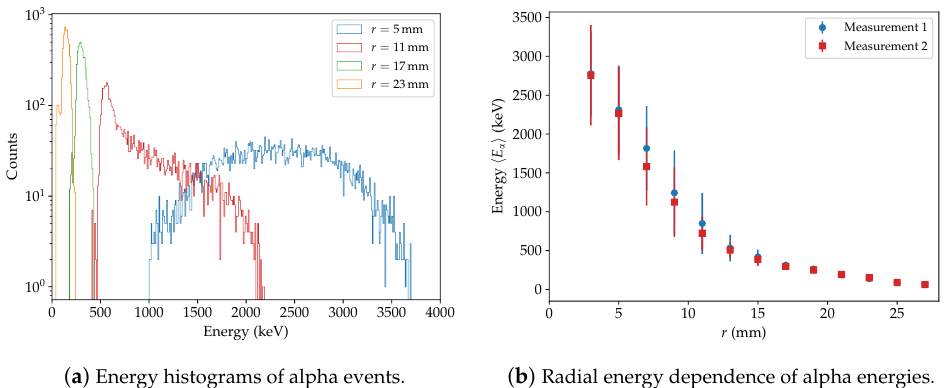
Figure 9. Radial dependence of the observed energy of alpha events: ( a ) Energy spectra of the alpha populations at selected radial positions after the application of multivariate cuts. ( b ) Mean observed alpha energy as a function of radius r for two radial 241 Am scans at different azimuthal E obs α (cid:104) (cid:105) positions. Error bars represent the standard deviations of the constrained E obs α distributions. The measurements were conducted with the detector operated at a bias voltage of V B =